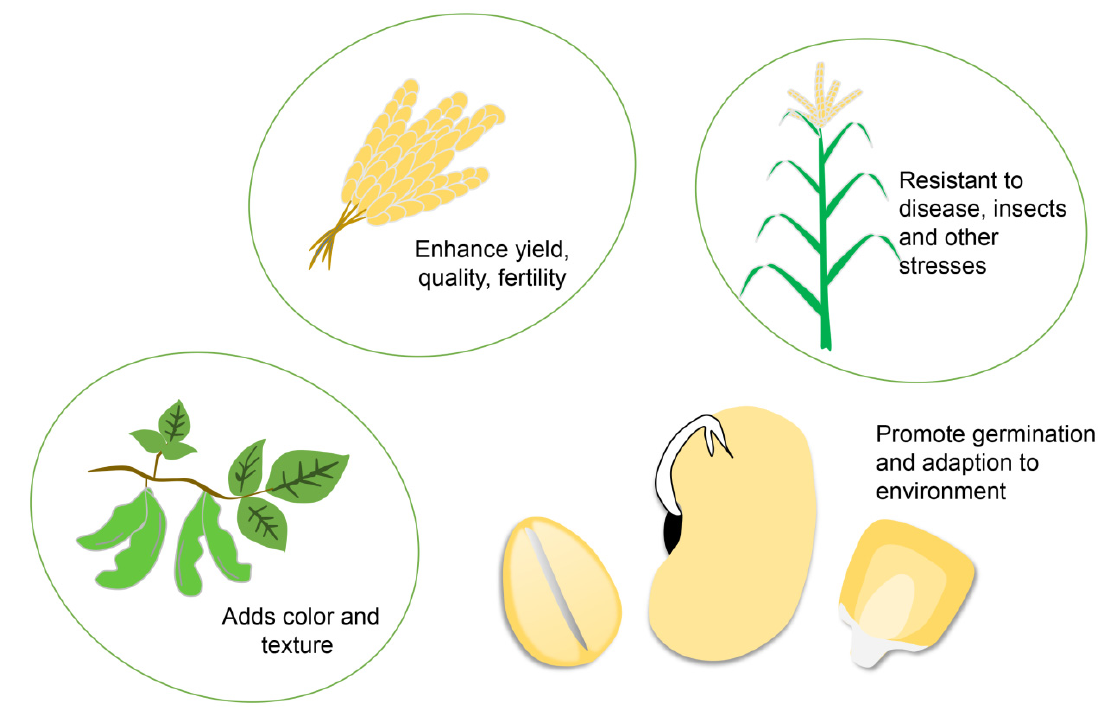
Figure 1. Breeding indicators that can be improved using bioinformatics. Breeding aims to inte- grate various indicators such as yield, quality, fertility, disease resistance, insect resistance, collapse resistance, as well as salt resistance and adaptability to adverse environments such as drought, waterlogging, high temperature, low temperature, and salinity to achieve superior varieties.